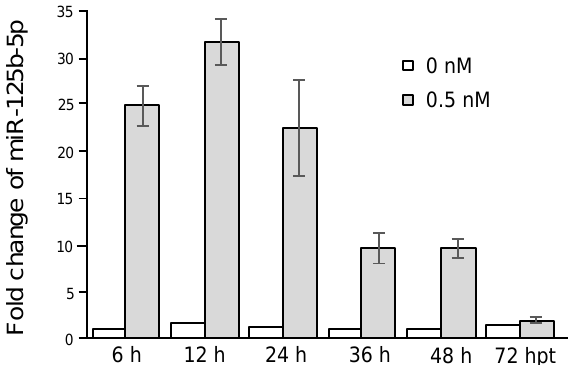
Figure 3. Transfected miR-125b-5p mimics lasted for 72 h. BHK-21 cells were mock-transfected or transfected with miR-125b-5p at 0.5 nM. Total RNA was extracted at 6, 12, 24, 36, 48, and 72 hpt. The RNA was subjected to an RT reaction and analyzed by RT-PCR. The relative fold change was normalized to endogenous U6 snRNA. Bars represent the mean ± SD ( n = 3).